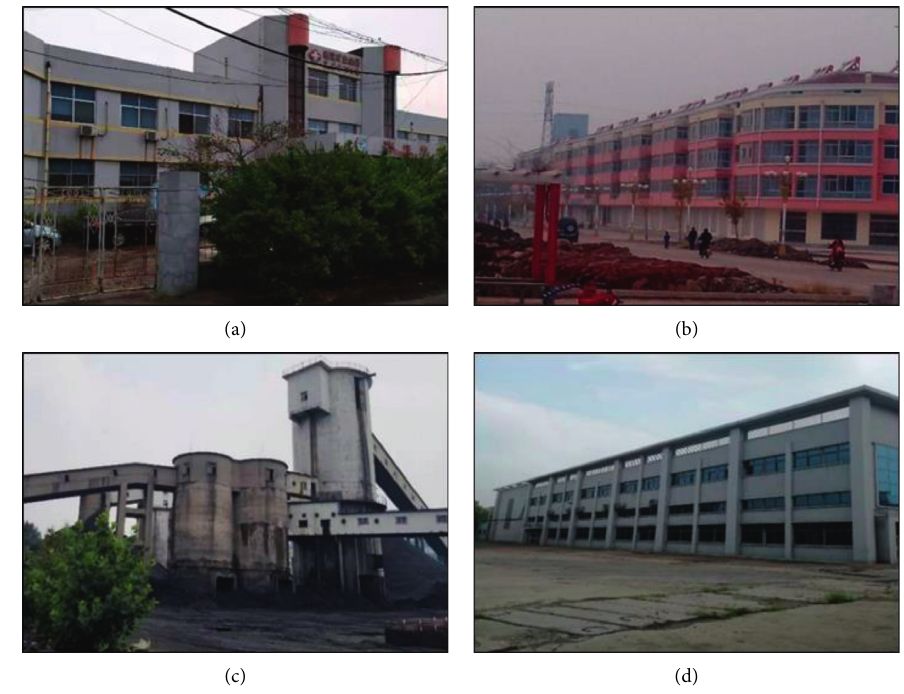
Figure 2: Photos of above-ground buildings: (a) hospital, (b) village, (c) coal washery, and (d)